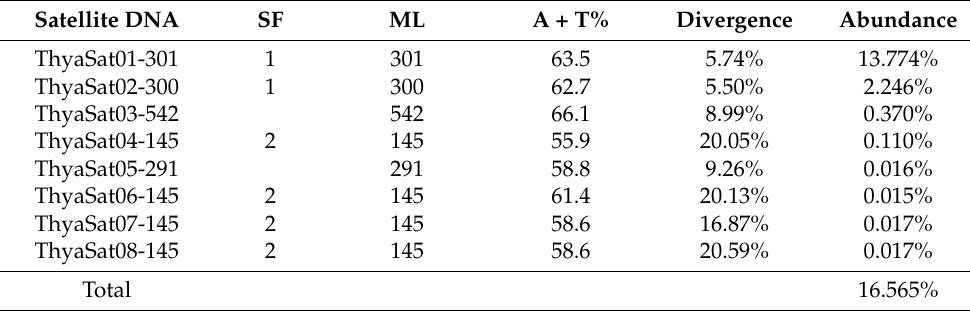
Figure 1. Satellite DNAs populating the genome of T. hyalinata . ( A ) Agarose gel showing the enzymatic digestion with HinfI that revealed occurrence of ladder pattern; one asterisk (monomer) and two asterisks (dimer). ( B ) Agarose gel after PCR amplification of ThyaSat01-301 showing the ladder pattern; quantity of asterisks corresponds to monomer multiples. ( C ) Relative abundance of the four most abundant satDNAs identified by RepeatExplorer. ( D ) Upper panel shows the alignment of consensus sequences obtained by restriction enzyme (ENZ) and by RepeatExplorer (REP) for ThyaSat01-301; note that the sequences are highly similar. The lower panel shows the consensus sequence from cloned fragments, and arrows indicate the restriction sites. * monomer, ** dimer, *** trimer and **** tetramer. Table 2. Main attributes of satDNAs characterized from T. hyalinata